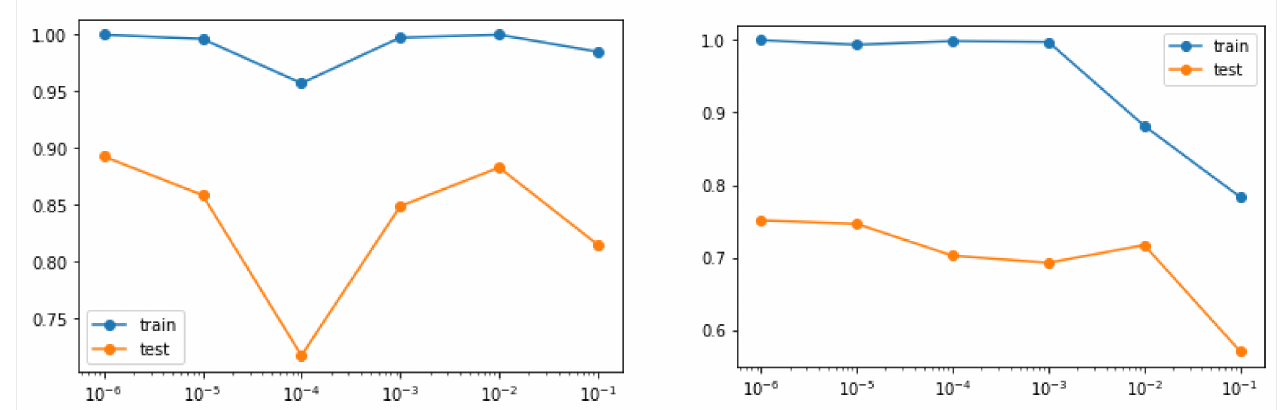
Figure 17. Accuracy plot of the grid search of regularization parameter (DenseNet-121 and Resnet50V2 models).